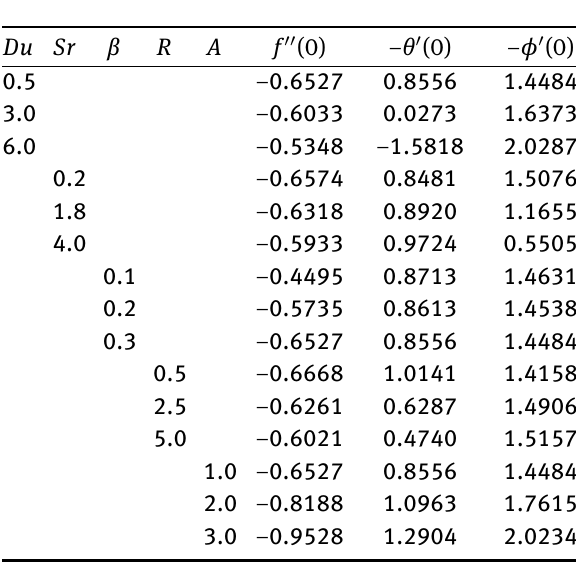
Table 1: The influence of various physical parameters on skin fric- tion, heat and mass transfer coeflcients.